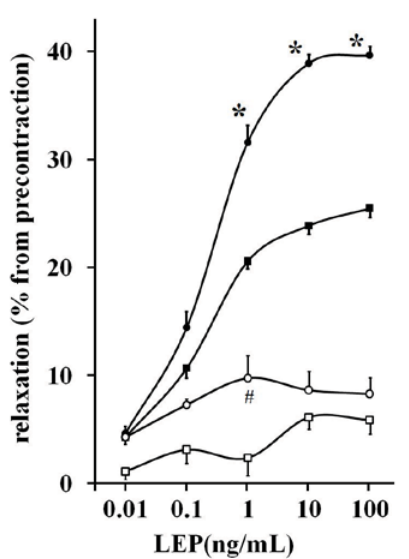
Figure 2. Vascular response of pulmonary artery rings from normal rats precontracted with phenylephrine to increasing doses of leptin (LEP), either alone (filled squares) or after preincubation with the apelin (filled circles). The vehicle effects alone or in the presence of AP13 are presented as empty squares and circles. *P<0.01 in the presence of AP13 as compared with LEP effects alone (n=6). #P<0.05 in the presence of AP13 as compared with vehicle alone (n=6). The LEP or vehicle effects are expressed as a percentage of Phe-induced precontraction (mean ±